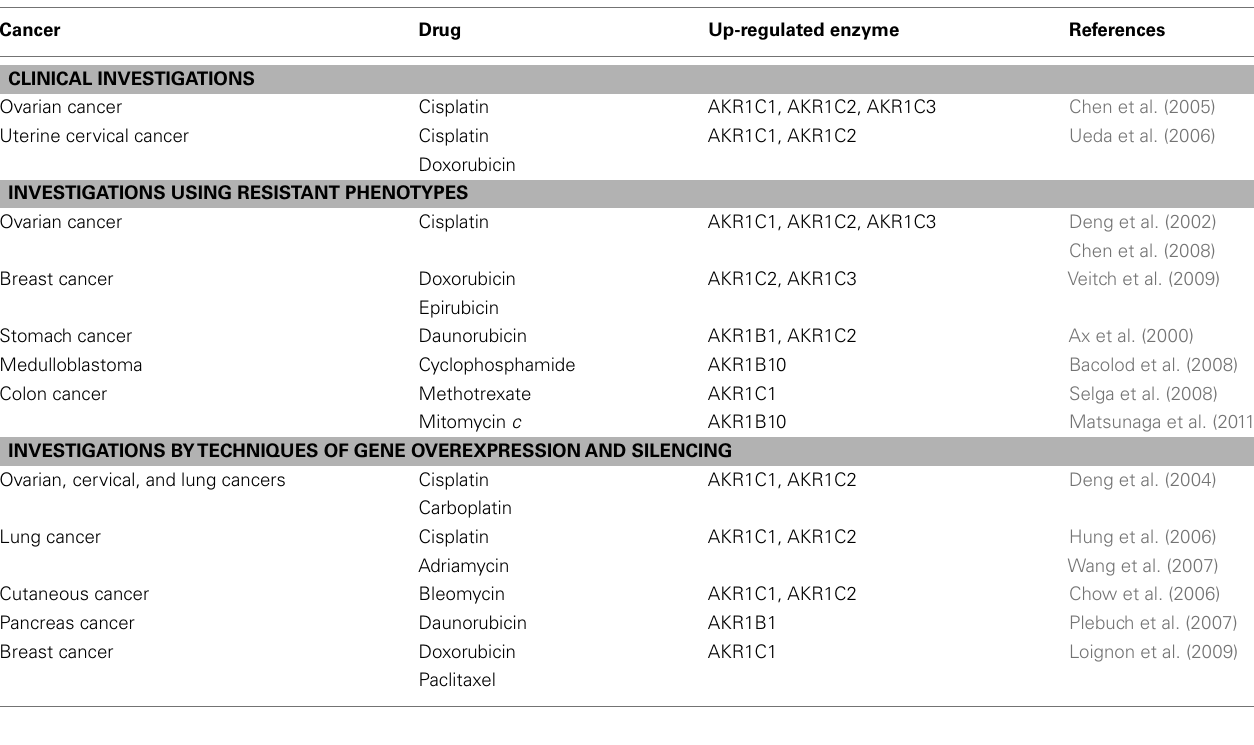
Table 1 | Expression ofAKRs in chemoresistant cancer cells.